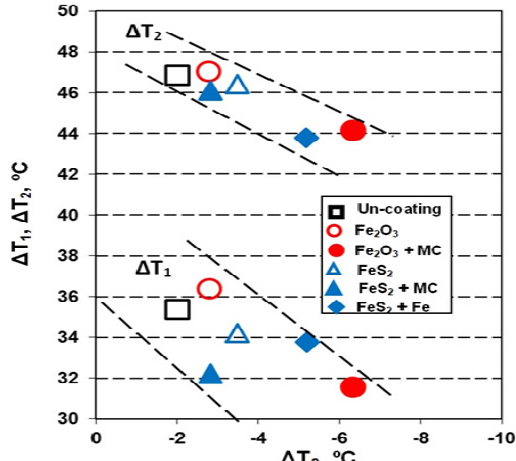
Figure 5. Relationship between the solidification undercooling at the lowest ( ∆ T 1 ) and the highest ( ∆ T 2 ) eutectic reaction and at the end of solidification ( ∆ T 3 ) compared to metastable (carbidic) eutectic temperature (T mst ) for uncoated and different inner-coated ceramic cups.